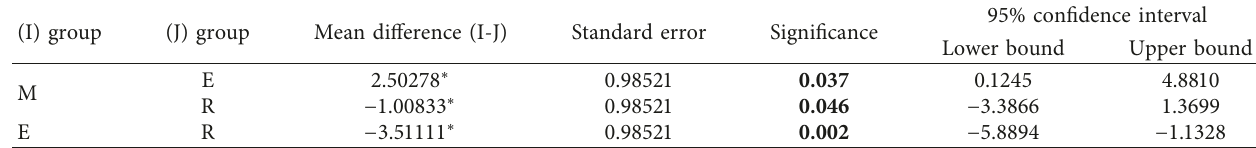
Table 3: Tukey post hoc test for the uptake scores.